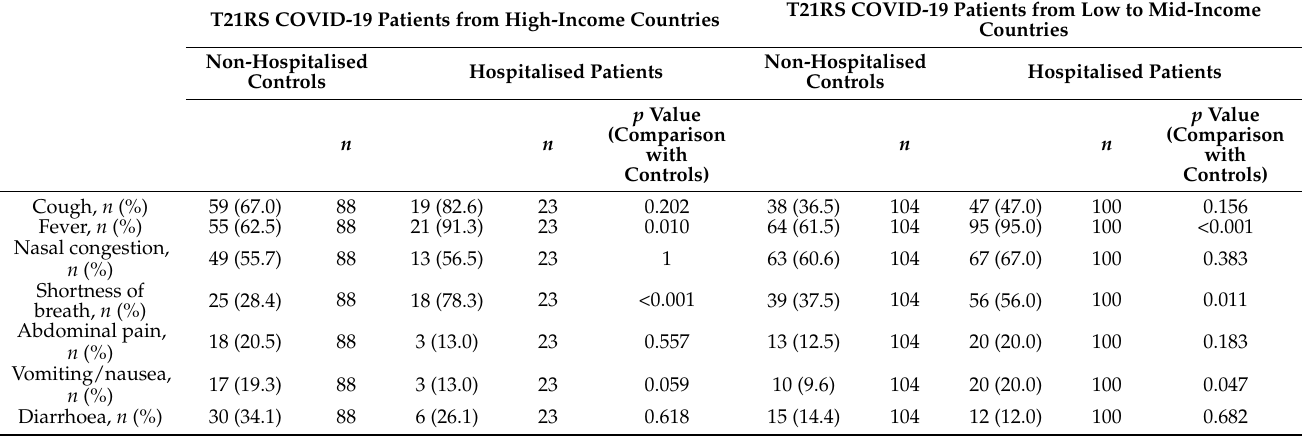
Table A4. Signs and symptoms related to COVID-19 in individuals with Down Syndrome comparing hospitalised with non-hospitalised patients, stratified by high-income and low to middle-income countries. T21RS COVID-19 Patients from High-Income Countries T21RS COVID-19 Patients from Low to Mid-Income Countries Non-Hospitalised Non-Hospitalised Controls Hospitalised Patients